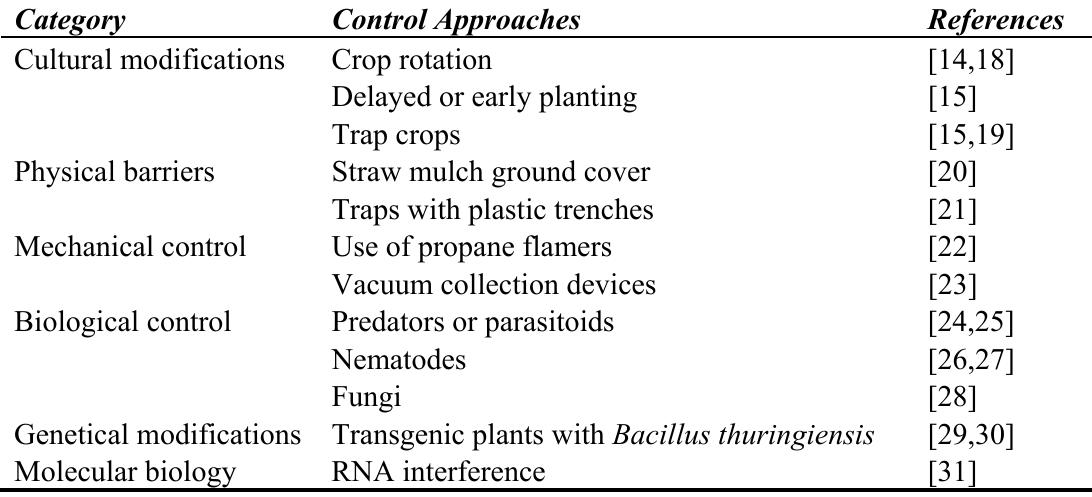
Table 1. Different approaches suggested to control the Colorado potato